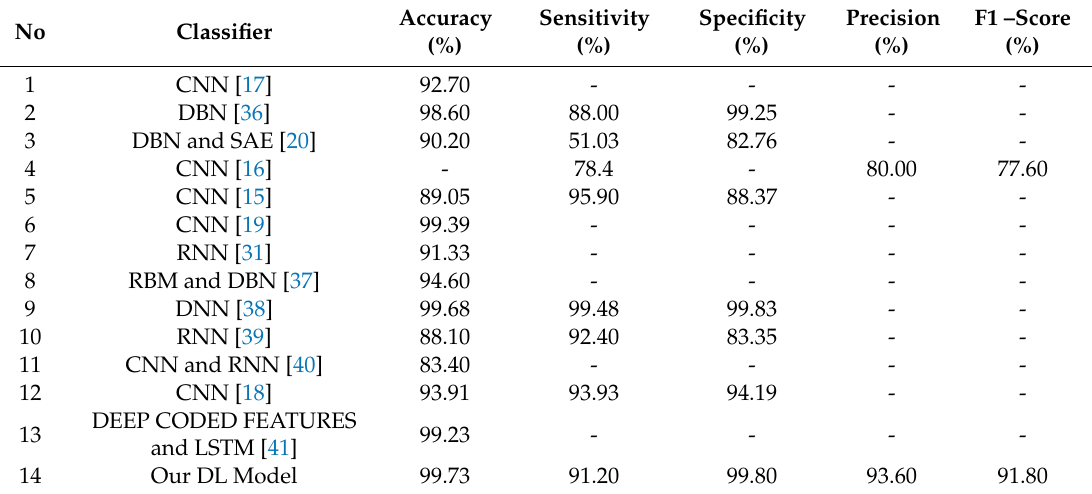
Table 9. Selected literatures for benchmarking our proposed